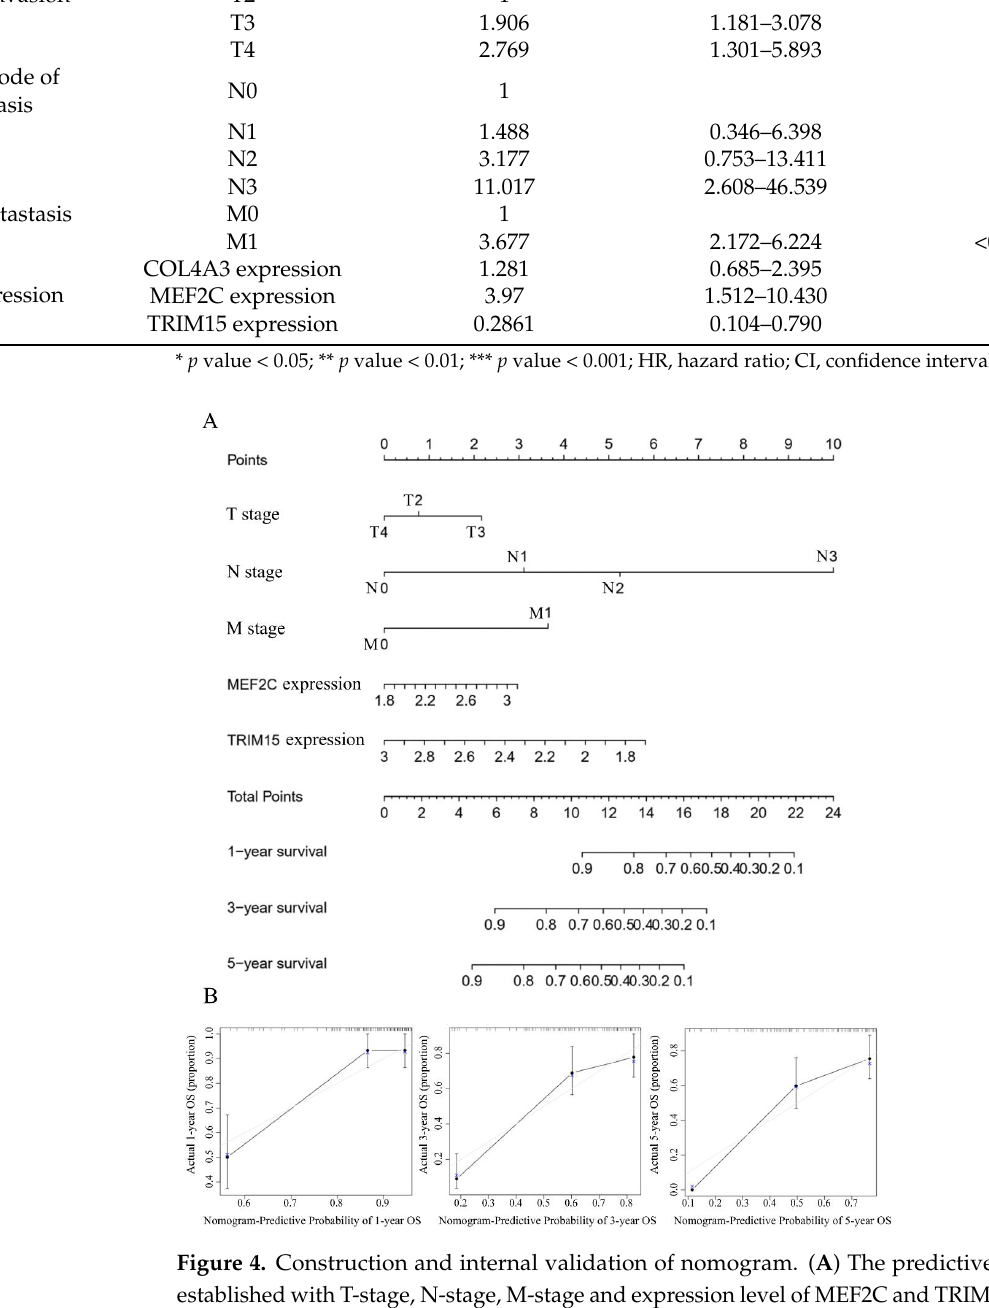
difference in prognostic value between the high-risk and low-risk groups (Figure 5B). De- cision curve analysis showed the effectiveness of the nomogram was better than the sev- enth AJCC TNM staging system. For external validation, using the TCGA-STAD dataset, the results of ROC curves, Kaplan – Meier analysis and decision curve analysis were similar with the training set (GSE62254). The AUC of predicted 1-, 3- and 5-year overall survival were 0.61, 0.69 and 0.77, which were better than the TNM stating system (Figure 5D) in the TCGA-STAD